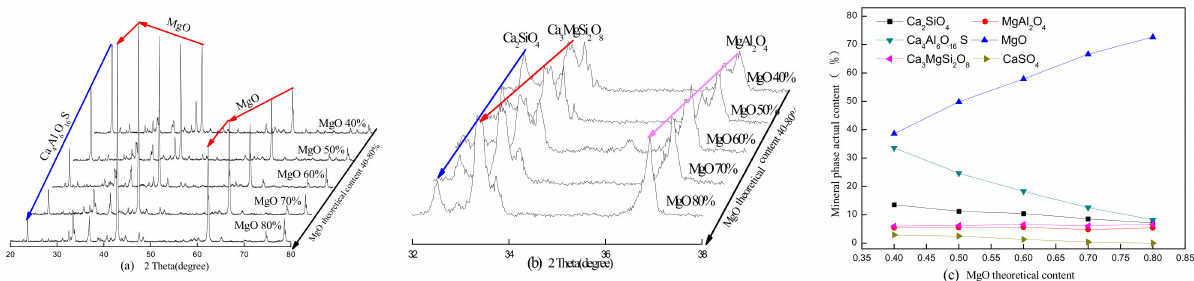
Figure 6. XRD patterns of the SAC-MKPC clinker with MgO theoretical content at 1300 ◦ C: ( a ) main phase; ( b ) minor phase; and ( c ) mineral phase actual